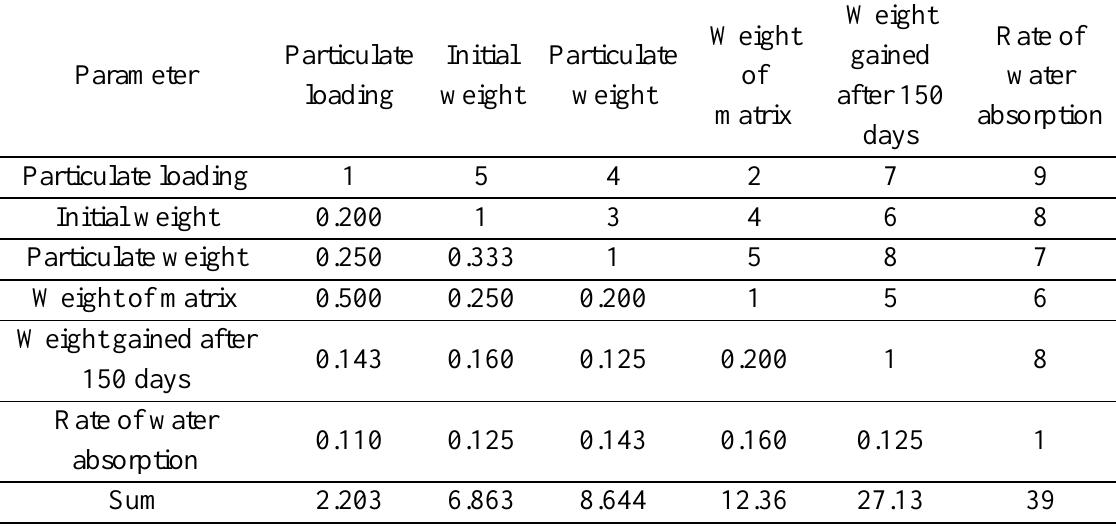
Table 9. The 6 x 6 matrix representing the values of the pairwise comparison for the cocoa pod husk composite.